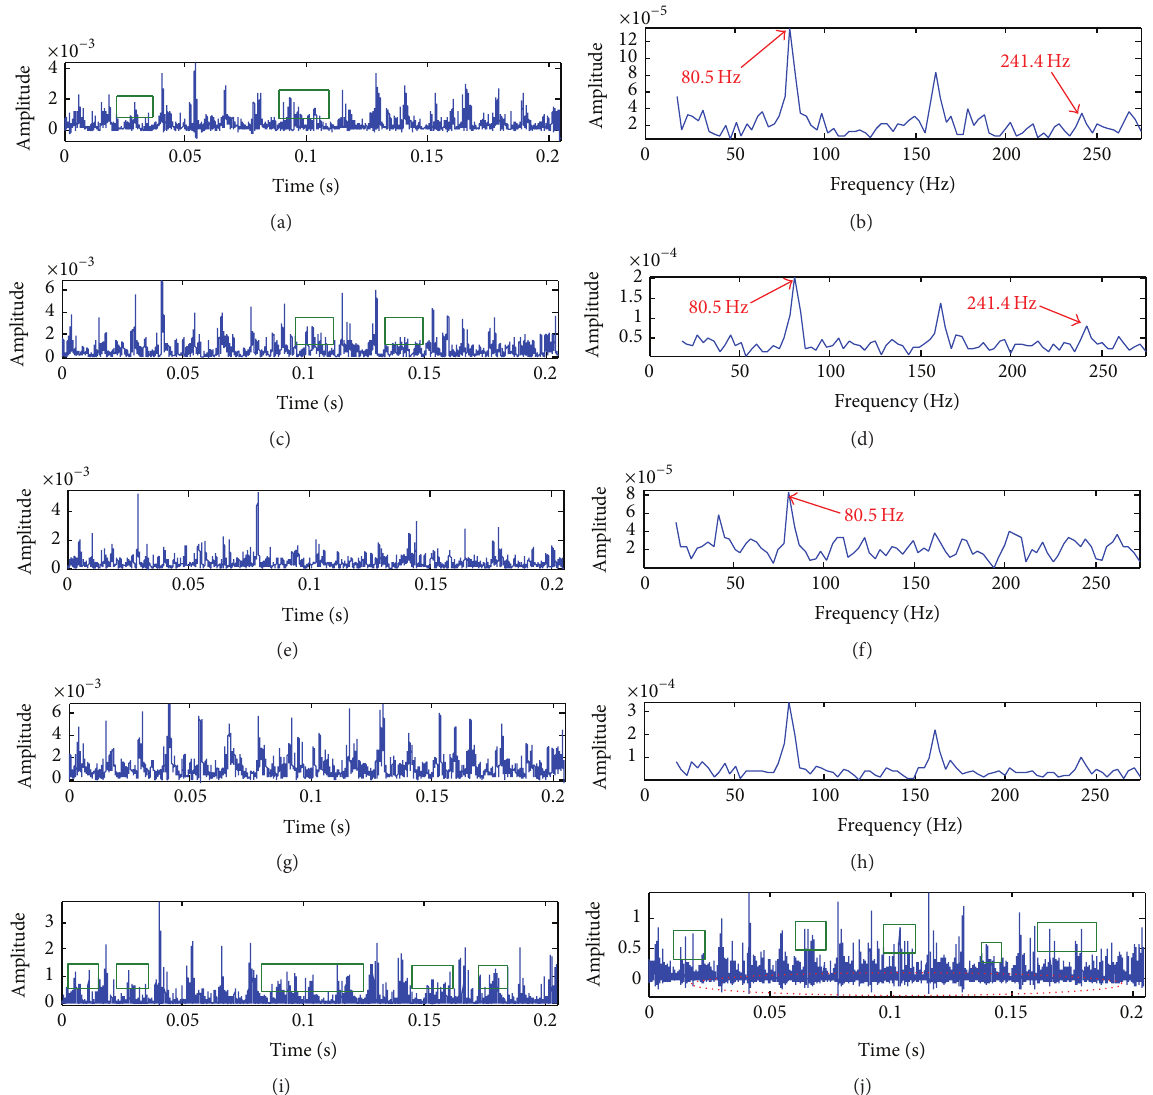
Figure 17: Enhanced waveform and its power spectrum by the proposed method: (a) enhanced waveform of the first mode by MTEO; (b) power spectrum of the first mode enhanced waveform by MTEO; (c) enhanced waveform of the second mode by MTEO; (d) power spectrum of the second mode enhanced waveform by MTEO; (e) enhanced waveform of the third mode by MTEO; (f) power spectrum of the third mode enhanced waveform by MTEO; (g) enhanced waveform of the combined mode by MTEO; (h) power spectrum of the combined mode enhanced waveform by MTEO; (i) enhanced waveform of the first mode by TEO; (j) enhanced waveform of the second mode by